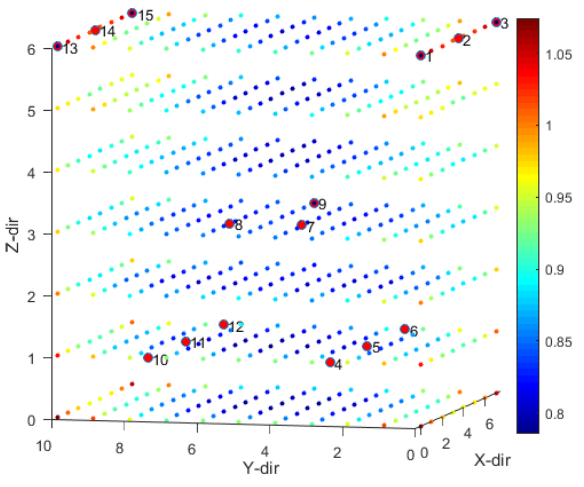
Figure 5. The total precision for possible user tag locations for the geometric configuration of 15 beacons.